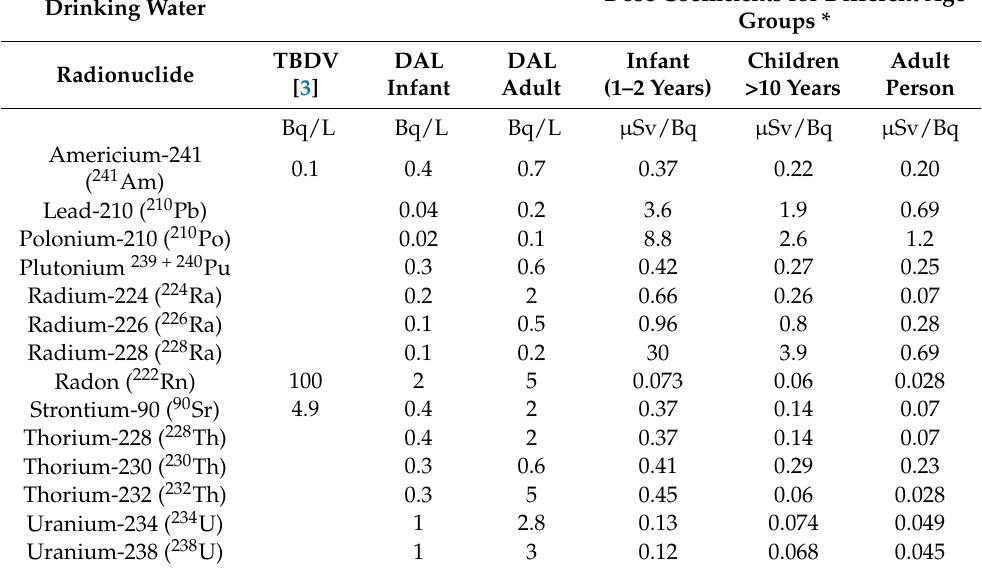
Table 1. Activity levels for drinking water in Switzerland and corresponding ingestion factors. DAL: derived activity limits calculated with Equation (1). * Dose coefficients for ingestion listed in the Swiss Radiological Protection Ordinance [5] based on ICRP-Publication 119 [1]. EU: Council Directive 2013/15/EURATOM